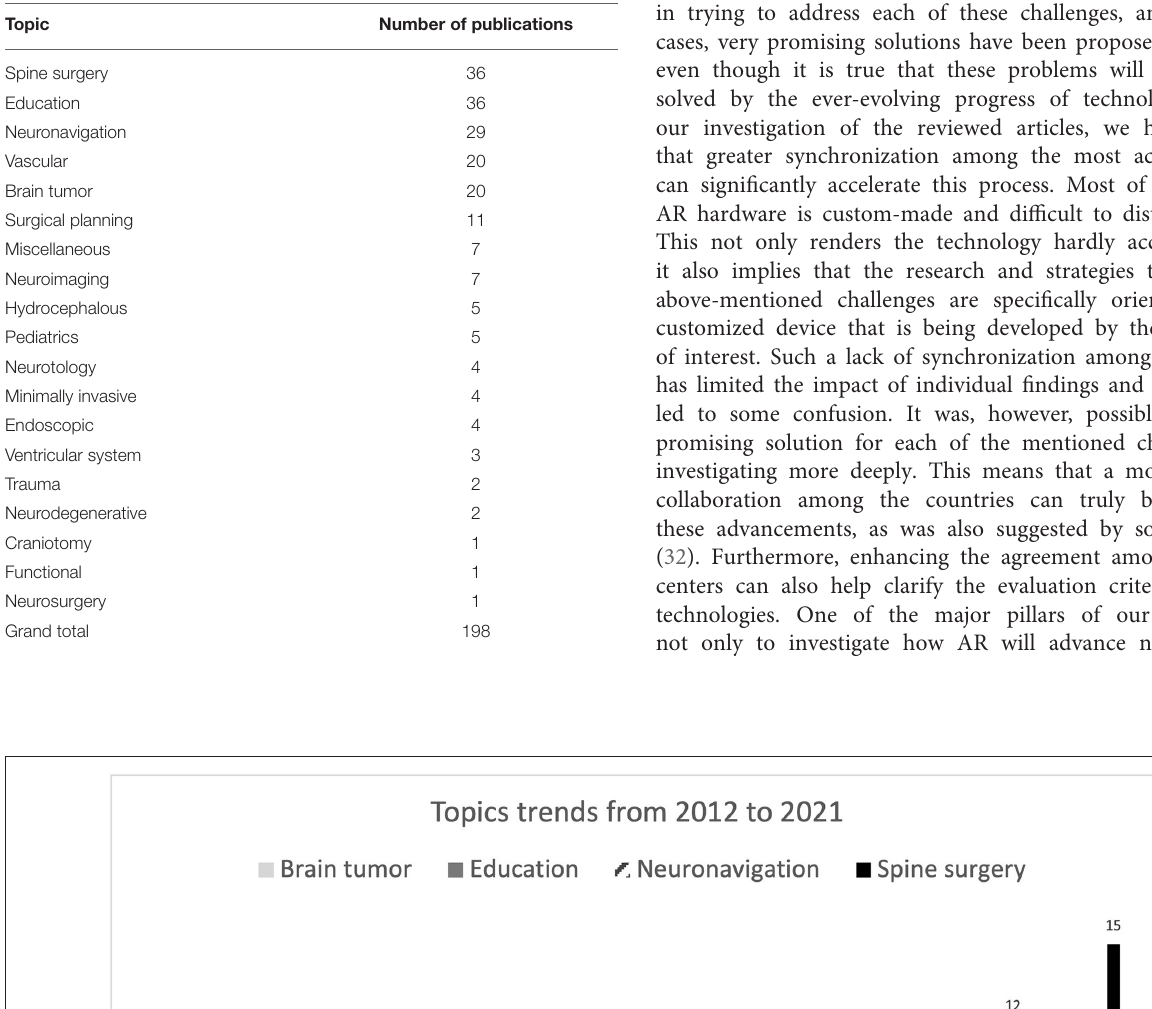
TABLE 3 | Number of publications that could be retrieved from the search as grouped by the field of application.